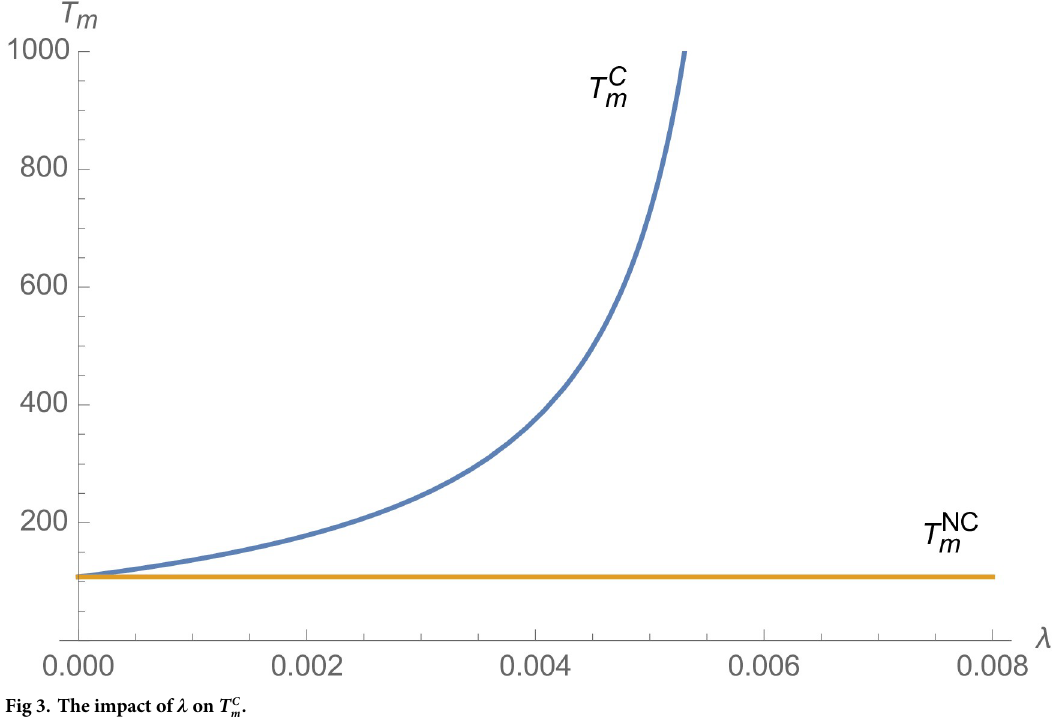
Fig 3. The impact of λ on T C